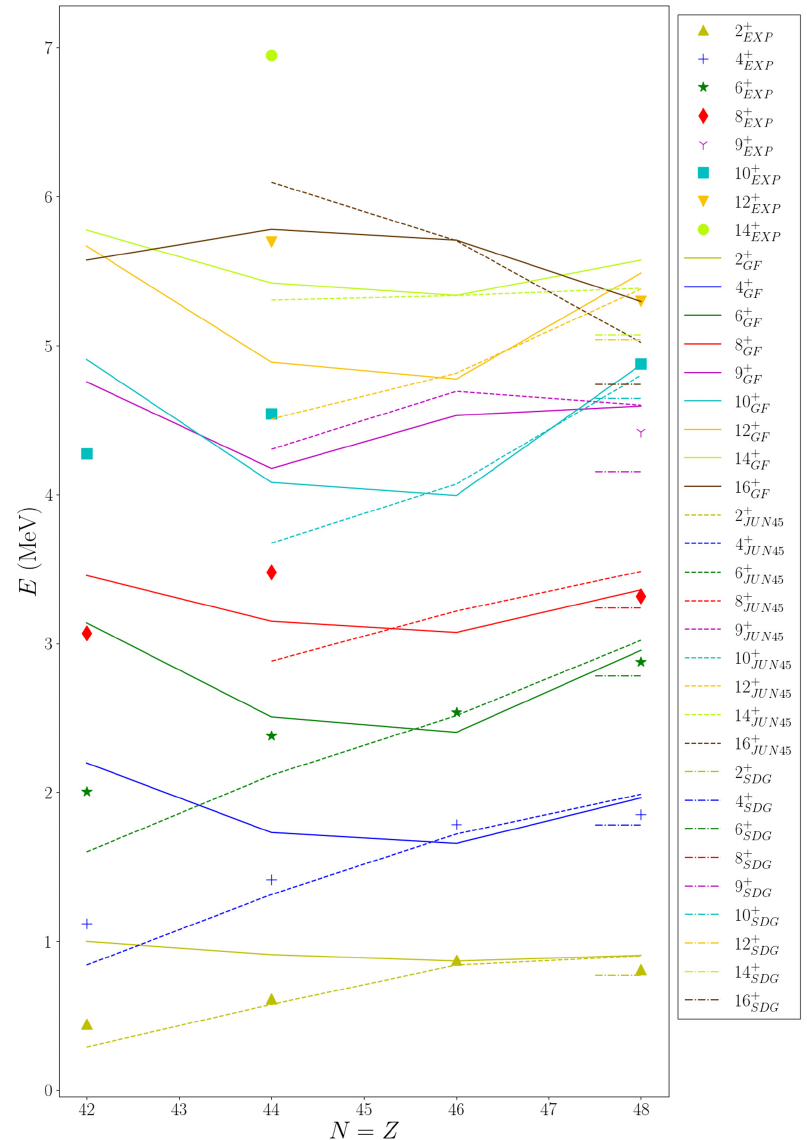
Figure 4. Excitation energies of the even–even N = Z nuclei in the g 9/2 shell with A (atomic mass number) = 84–96 for spins I π = 2 + –16 + . The spins of excited states in all isotopes are assigned tentatively [101]. Experimental energies are given with colored symbols distinguished by their spin values. Shell-model calculations are shown with solid lines with different colors for each spin for the GF [85] calculation, dashed line for the JUN45 calculation [78,107] and present work for the higher-spin states and colored and short dashed-dotted colored lines for SDG [110] calculation for 96 Cd.